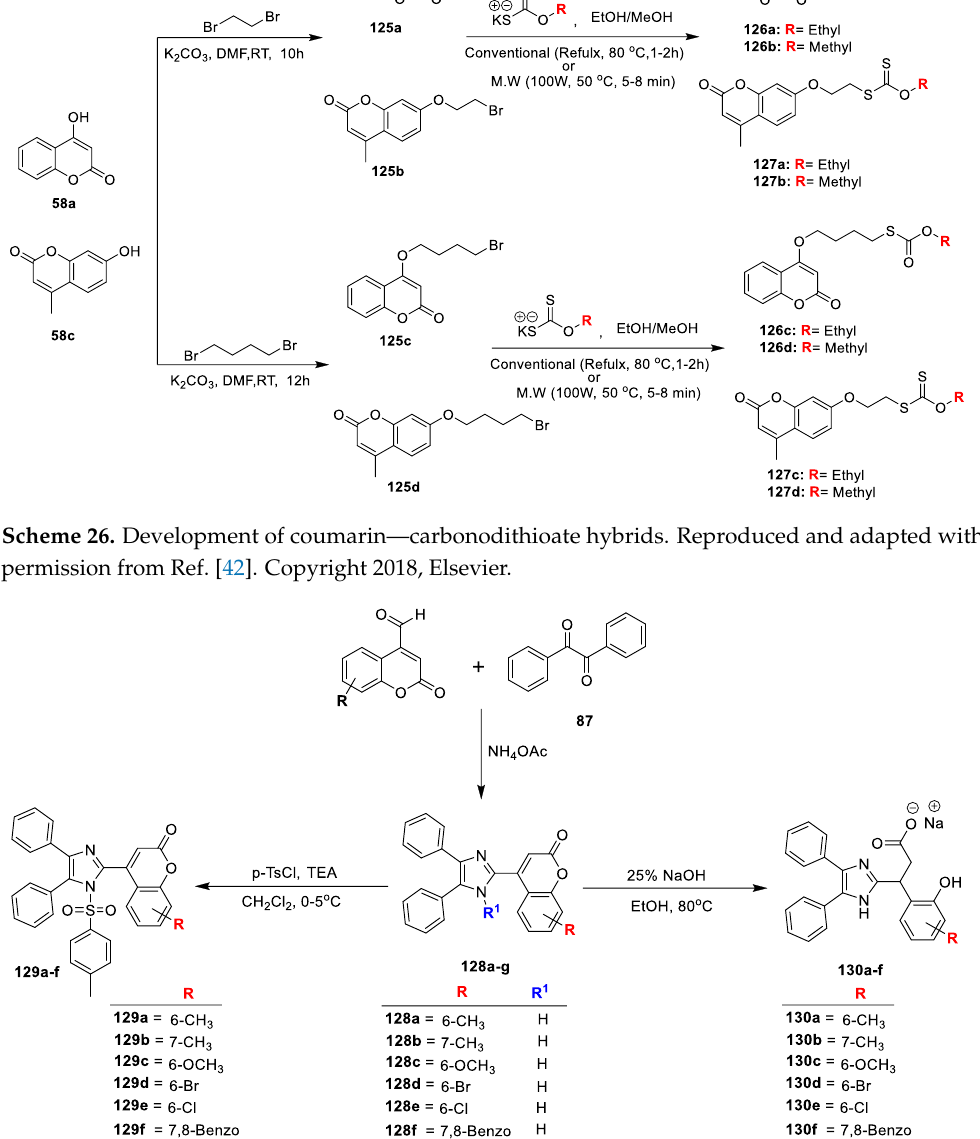
Figure 9. Hydrogen bonding interactions of compounds 130a and 130c with 1AI9 and 130c with N- myristoyl transferase (PDB ID: 4CAW). Among the series compound 133j was found to be highly active antibacterial candi- date against B. subtilis , S. aureus and E. coli (MIC 3.125 µg/mL) with zone of inhibition 19, 16 and 14 mm, respectively. Additionally, compounds 133e and 133i were found as prom- ising inhibitors against tested organism with MIC value of 6.25 µg/mL, while analogues